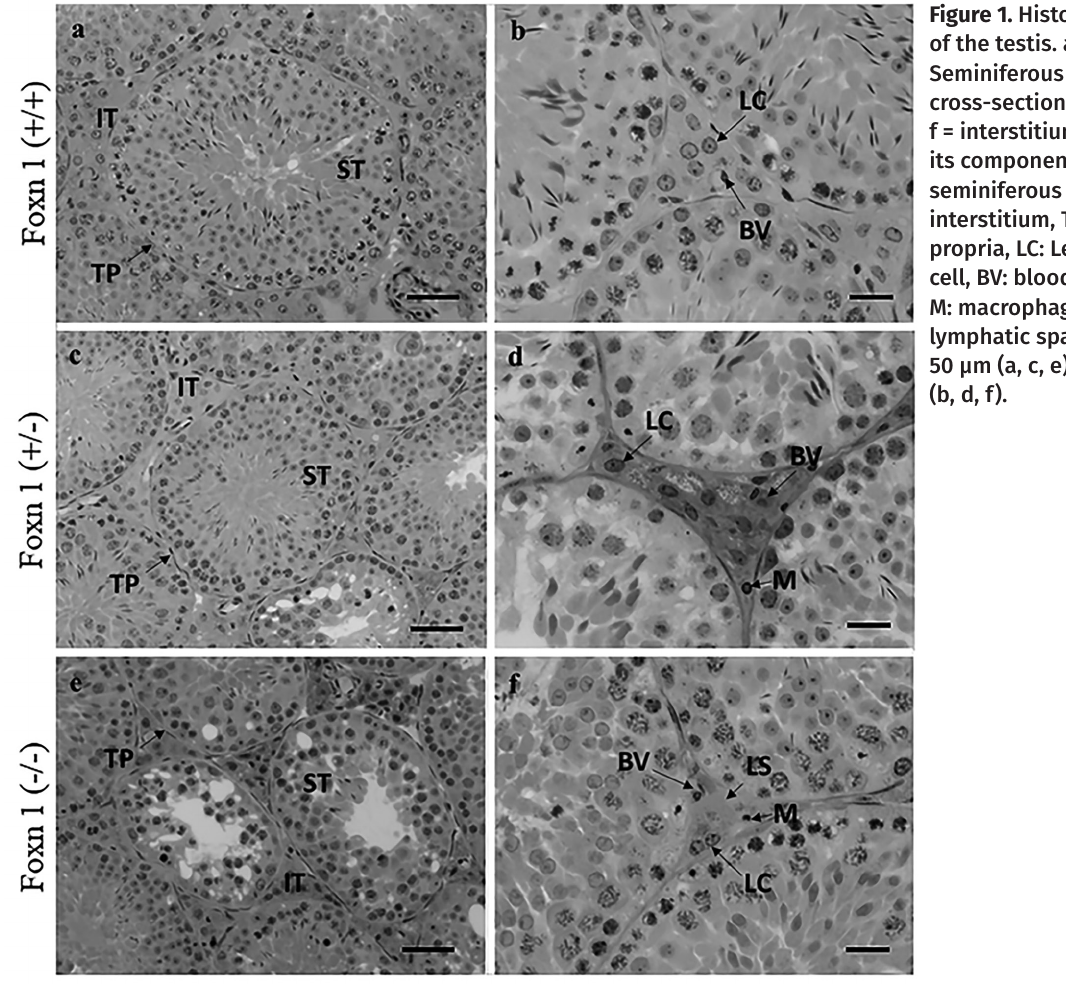
Figure 1. Histology of the testis. a, c, e = Seminiferous tubules cross-sections. b,